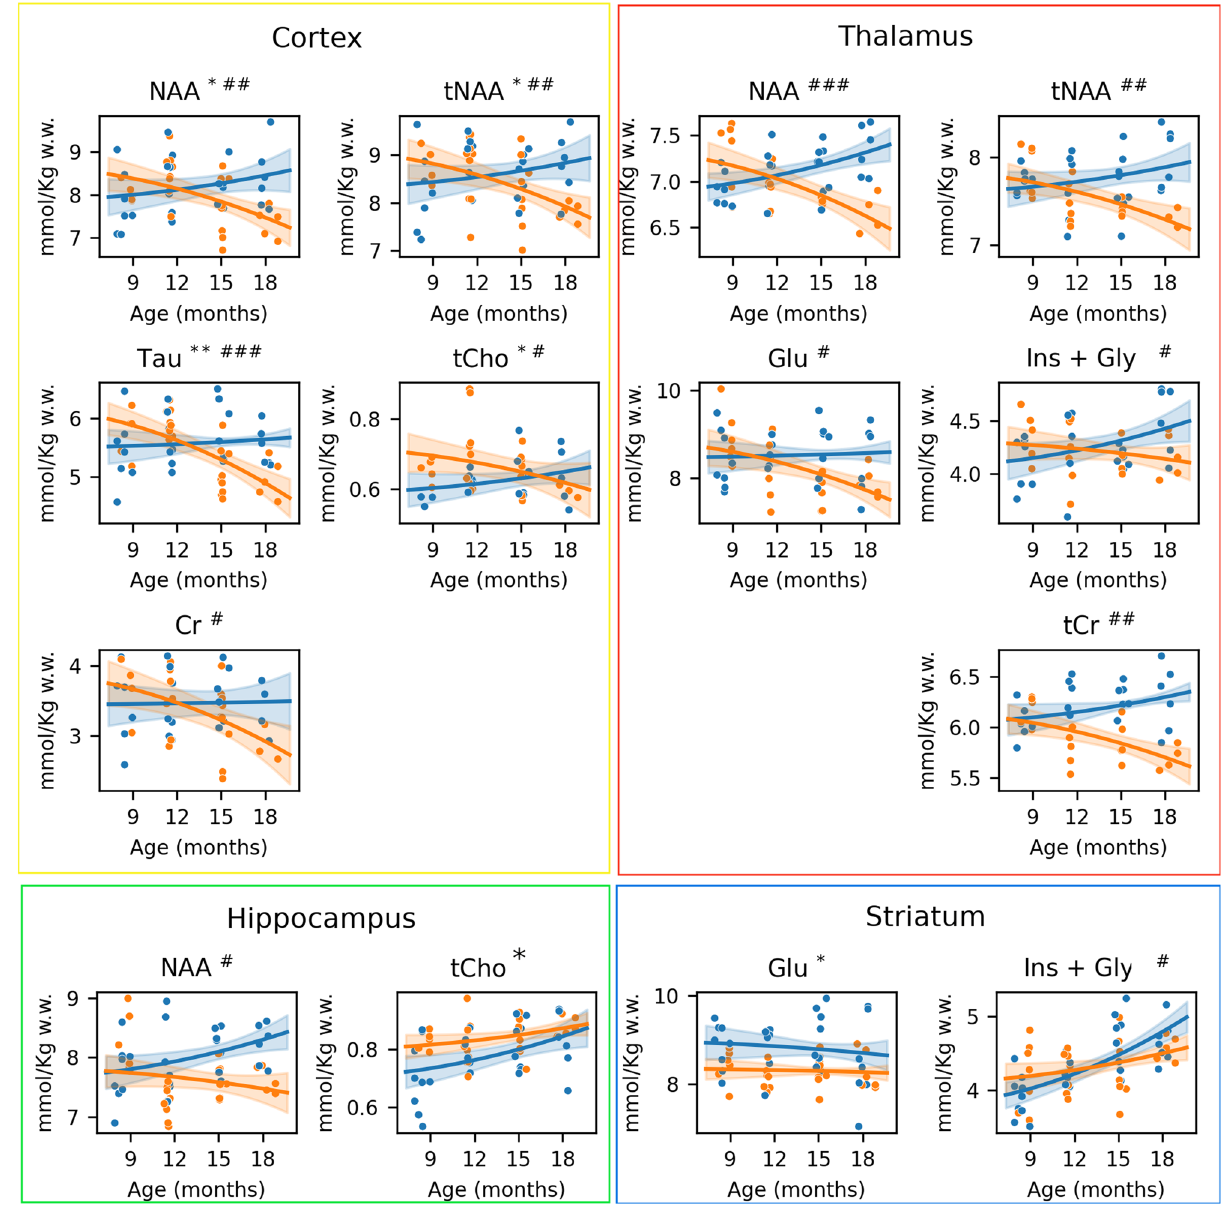
Figure 3. Longitudinal analysis of metabolite concentrations. Time-course metabolic changes in TgF344-AD (orange) and WT (blue) animals displaying only metabolites/regions with significant effect of group or group- age interaction in the LME model. Solid lines represent the LME model fitting, each dot corresponding to one sample (subject and time point). *: p -value of the group effect < 0.05; **: p -value of the group effect < 0.01; #: p -value of the group-age interaction < 0.05; ## p -value of the group-age interaction < 0.01; ###: p -value of the group-age interaction <